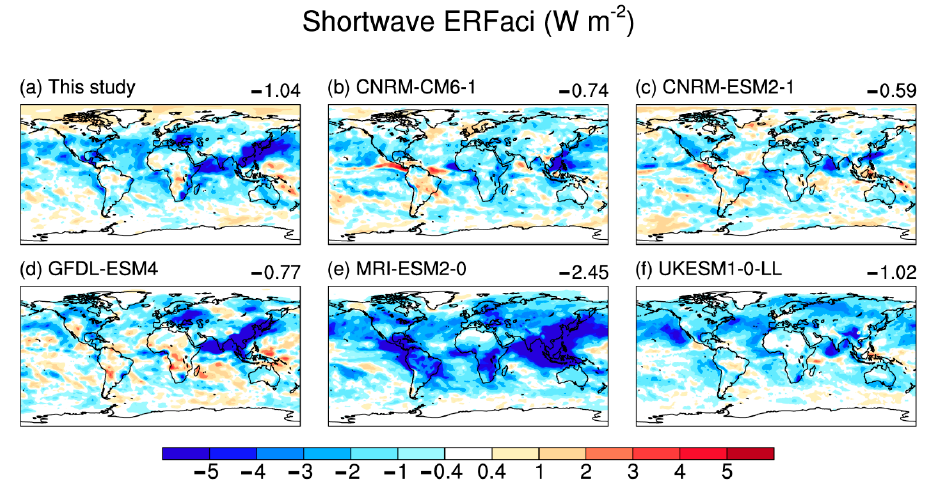
Figure 4. Comparison of annual mean shortwave effective radiative forcing of aerosol-cloud interactions in this study ( a ) and the five available ( b – f ) CMIP6 model results.